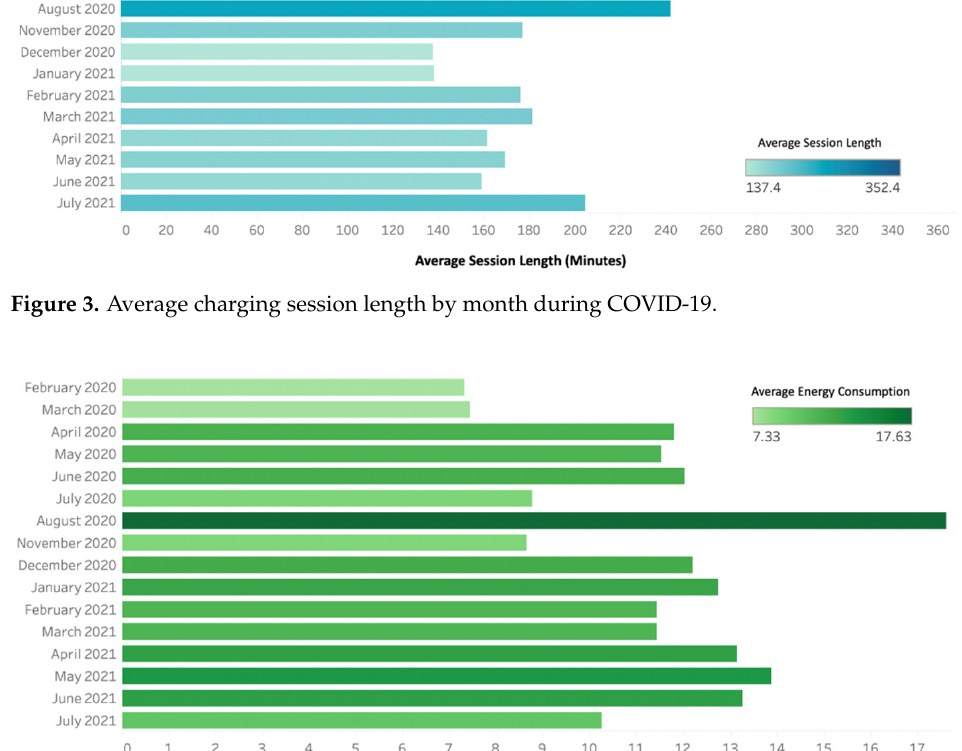
Figure 4. Average energy consumption by month during COVID-19.